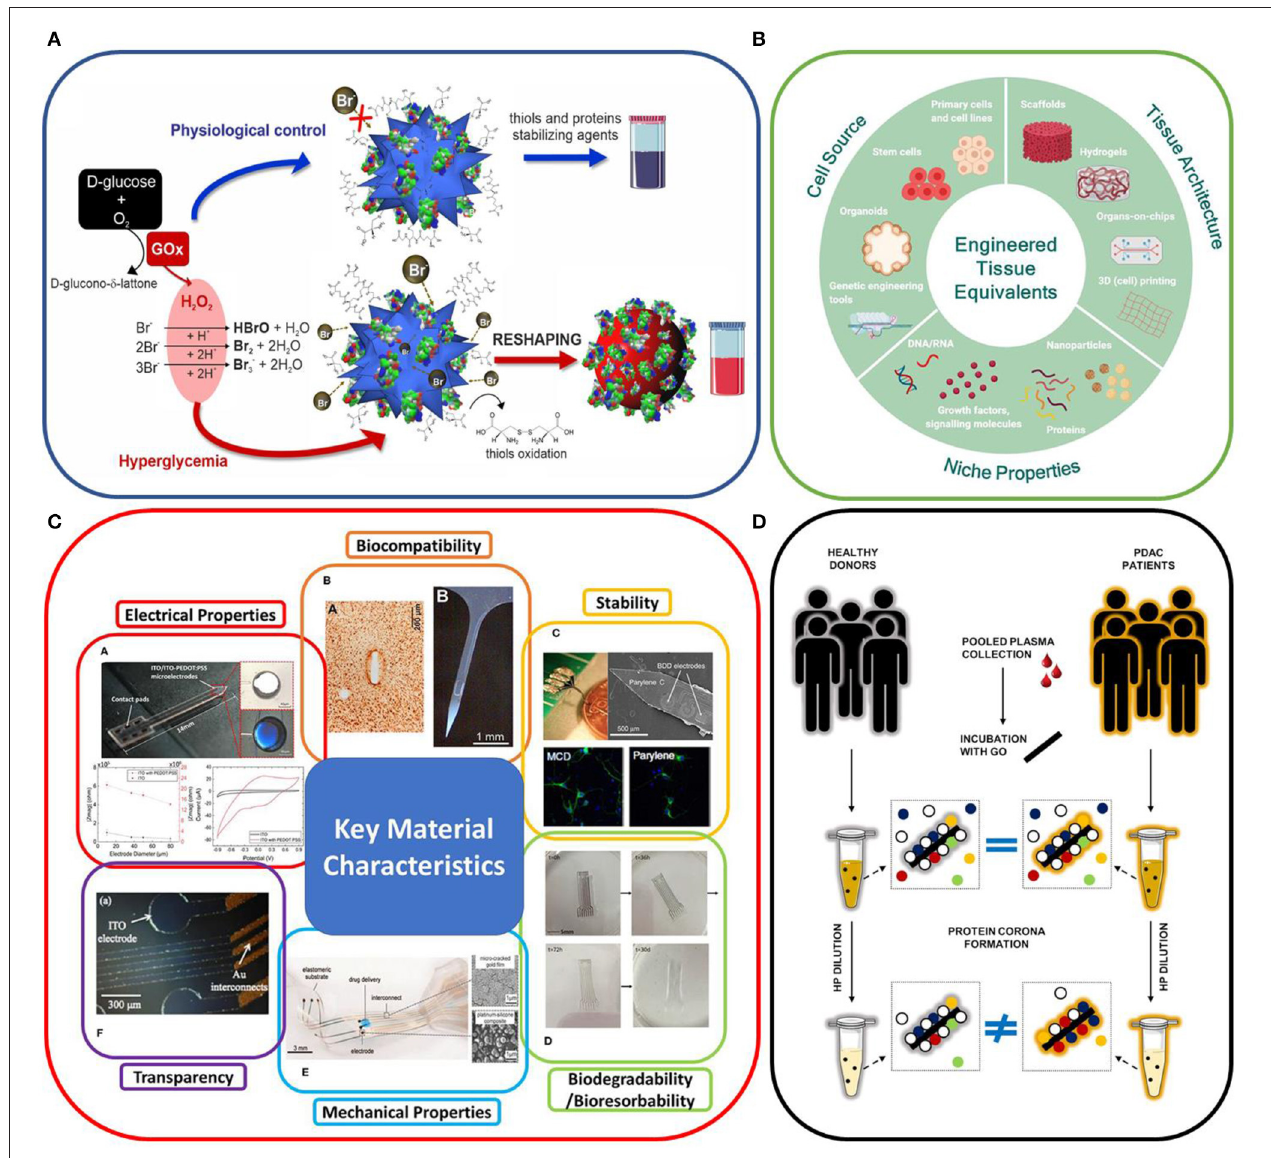
FIGURE 1 | (A) in vitro colorimetric assay using highly responsive multibranched gold nanoparticles (MGNPs) suspended in saliva: schematics of the mechanisms involved. From Donati et al. (B) Engineering human tissue equivalents in vitro ; from Moysidou et al. (C) Key material characteristics of neural recording implants. From Yang et al. (D) Cartoon describing the present understanding of the role of protein concentration on personalization of protein corona from Di Santo et